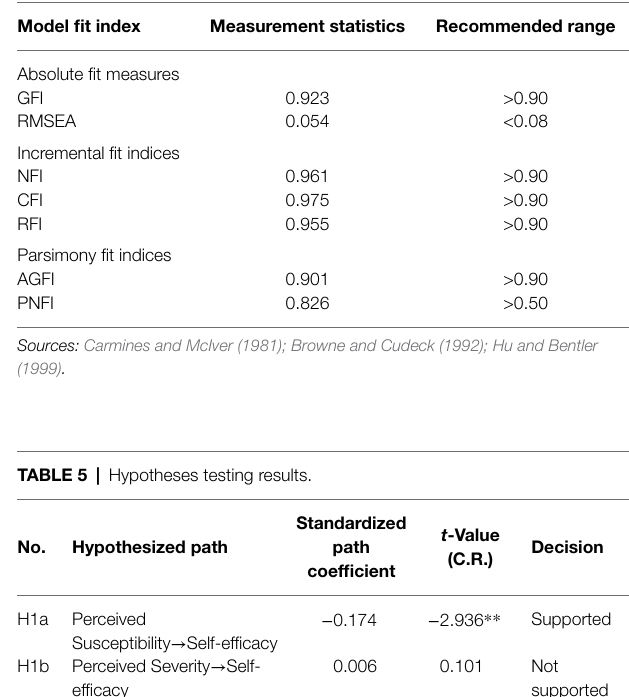
TABLE 4 | Goodness-of-fit indices.